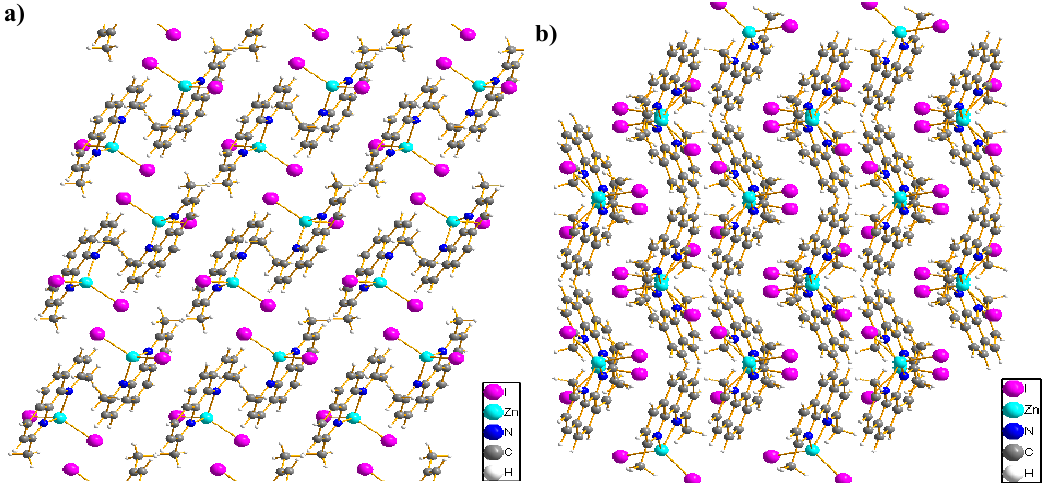
Fig. 5. A fragment of the 3D supramolecular compound 1, viewed along (a) the b direction, and (b) the c direction.